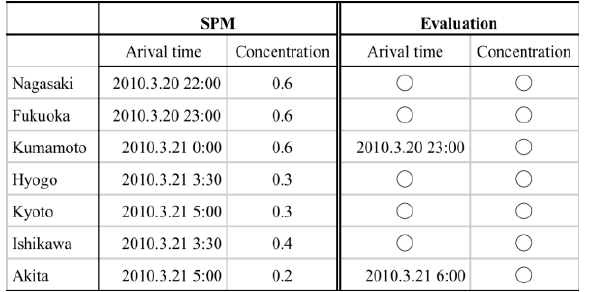
Table 1 Evaluation results for the arival time and the concentration of Asian dust (mg/m 3